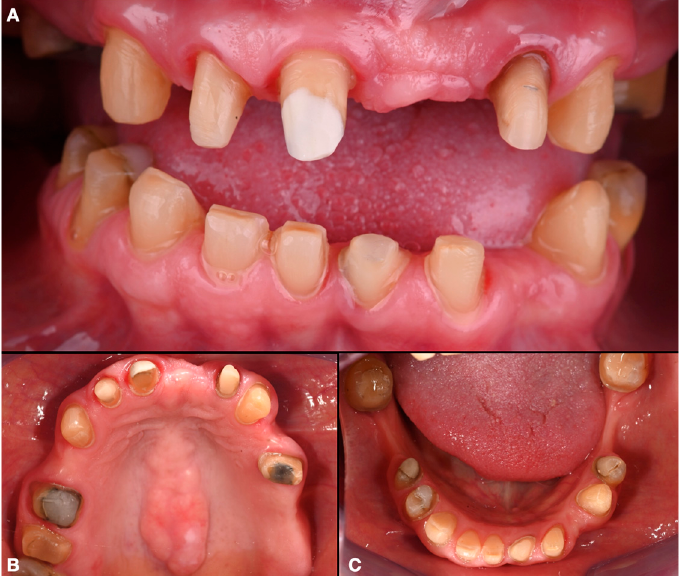
Figure 8. Full mouth preparations. ( A ) Frontal view. ( B ) Maxillary occlusal view. ( C ) Mandibular occlusal view.